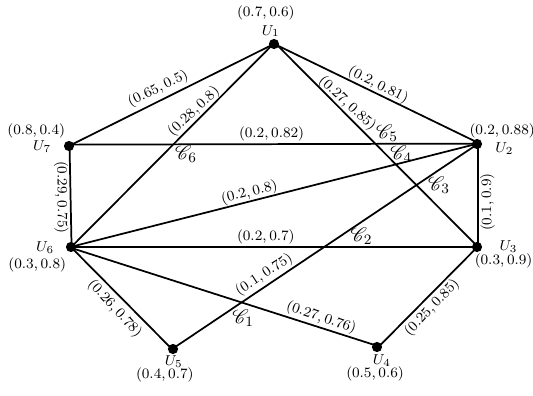
Figure 7.1: Transformer units connection Figure 18. Transformer units